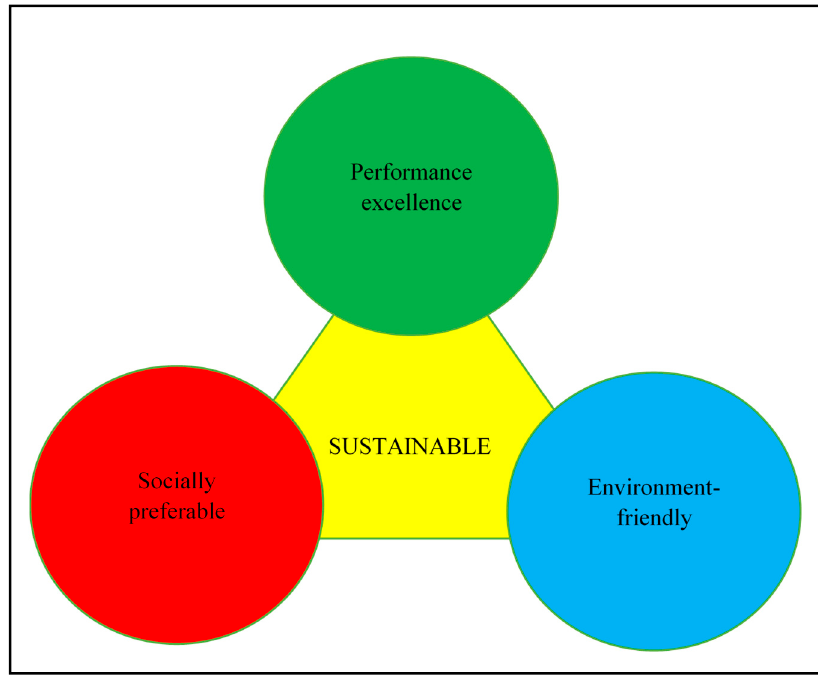
Figure 2. The triple bottom line (TBL) graphic [23].